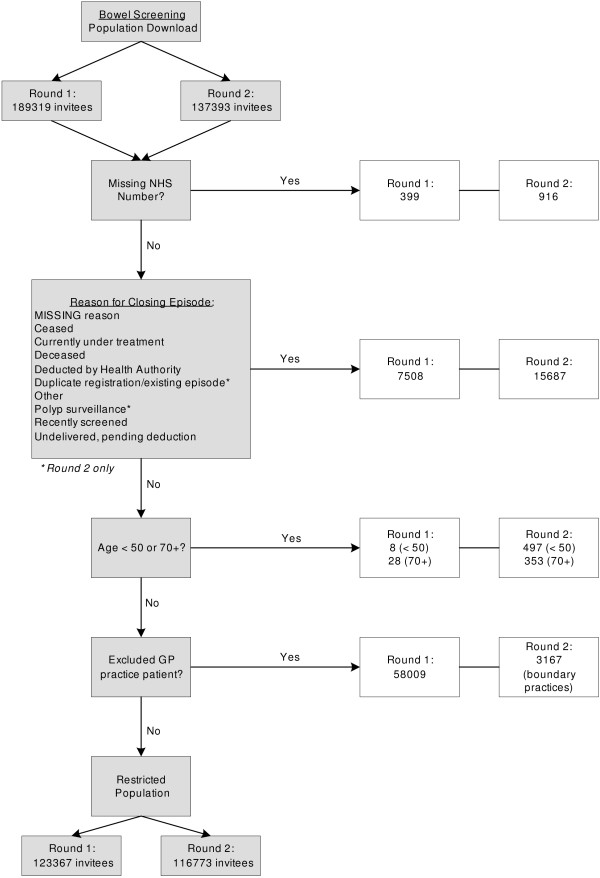
Flowchart detailing process for obtaining bowel screening populations for analysis.